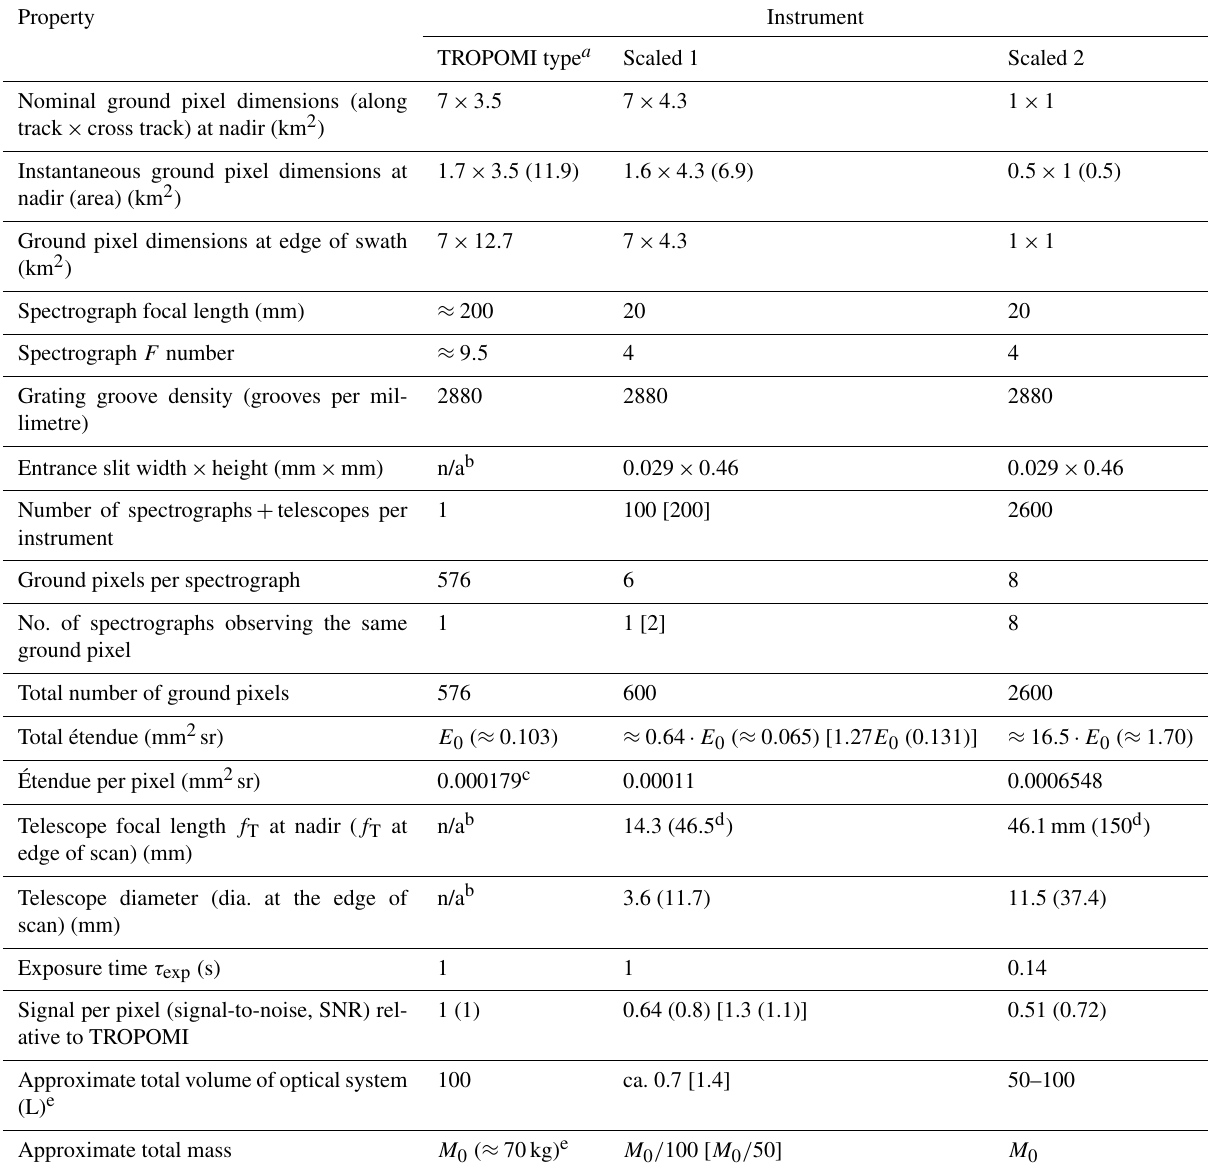
Table 2. Typical data of TROPOMI-Type and scaled satellite instruments working in the UV for a spectral resolution of ca. 0.5nm. “Scaled 1” refers to an instrument approximately matching the data of the TROPOMI UV–Vis part, employing 100 (variant A) or 200 (variant B) spectrographs + telescopes; the latter values are given in square brackets. “Scaled 2” refers to an instrument encompassing 2600 spectro- graphs + telescopes with 1km by 1km ground